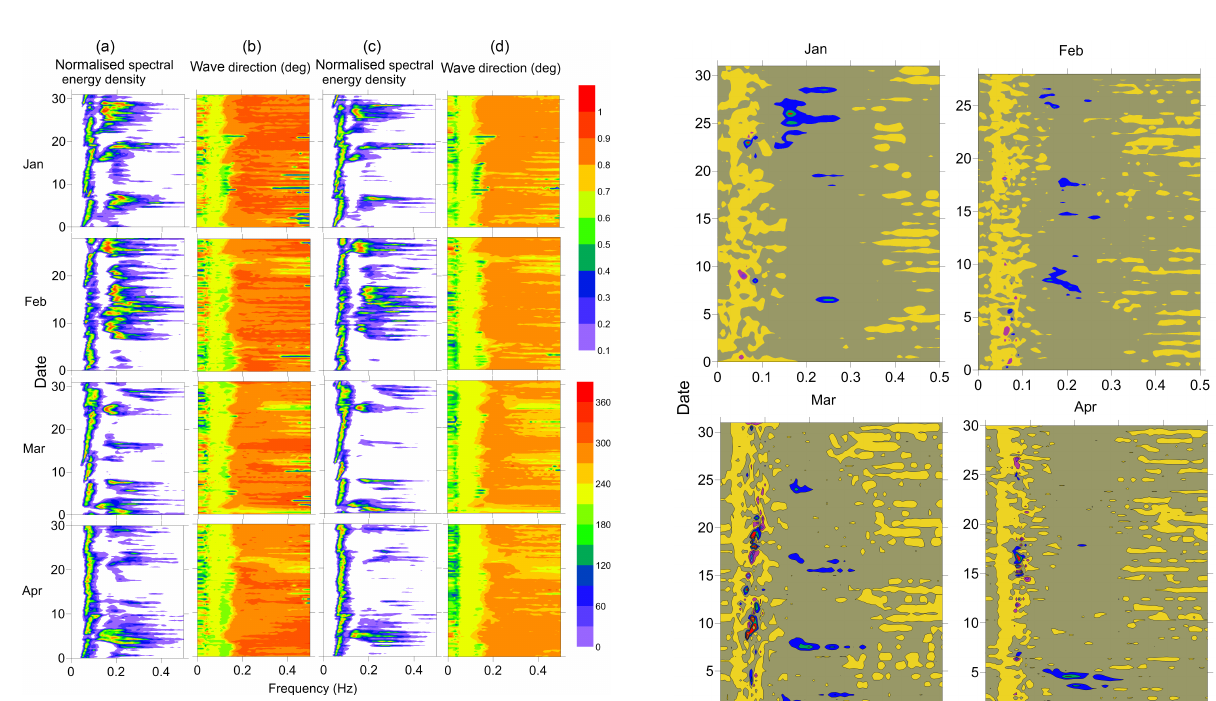
Figure 8. Plot of (a) normalized spectral energy density and (b) mean wave direction at 15m water depth in different months, (c) normalized spectral energy density and (d) mean wave direction at 5m water depth in different months. Figure 9. Plot of the difference in spectral energy density (m 2 Hz − 1 ) with different frequency at 15m water depth and 5m water depth in different